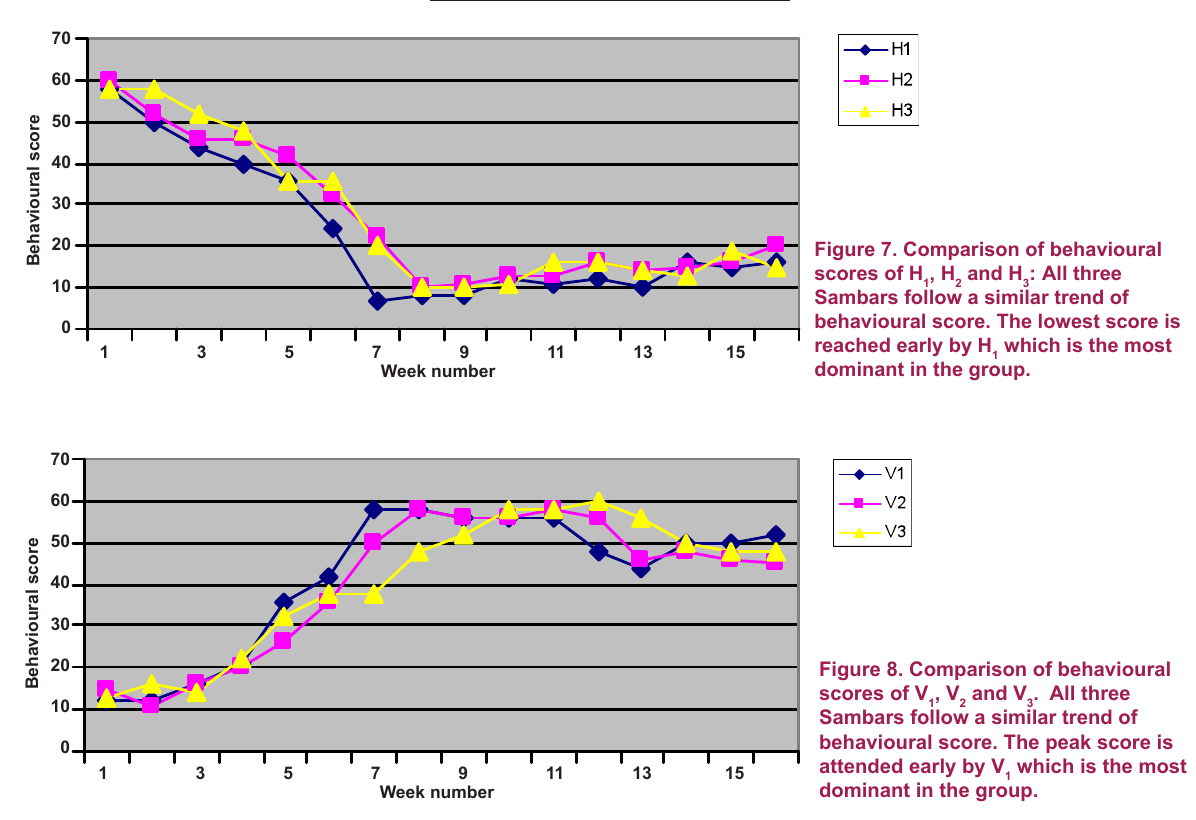
Figure 7. Comparison of behavioural scores of H , H and H : All three 1 2 3 Sambars follow a similar trend of behavioural score. The lowest score is reached early by H which is the most 1 dominant in the group.